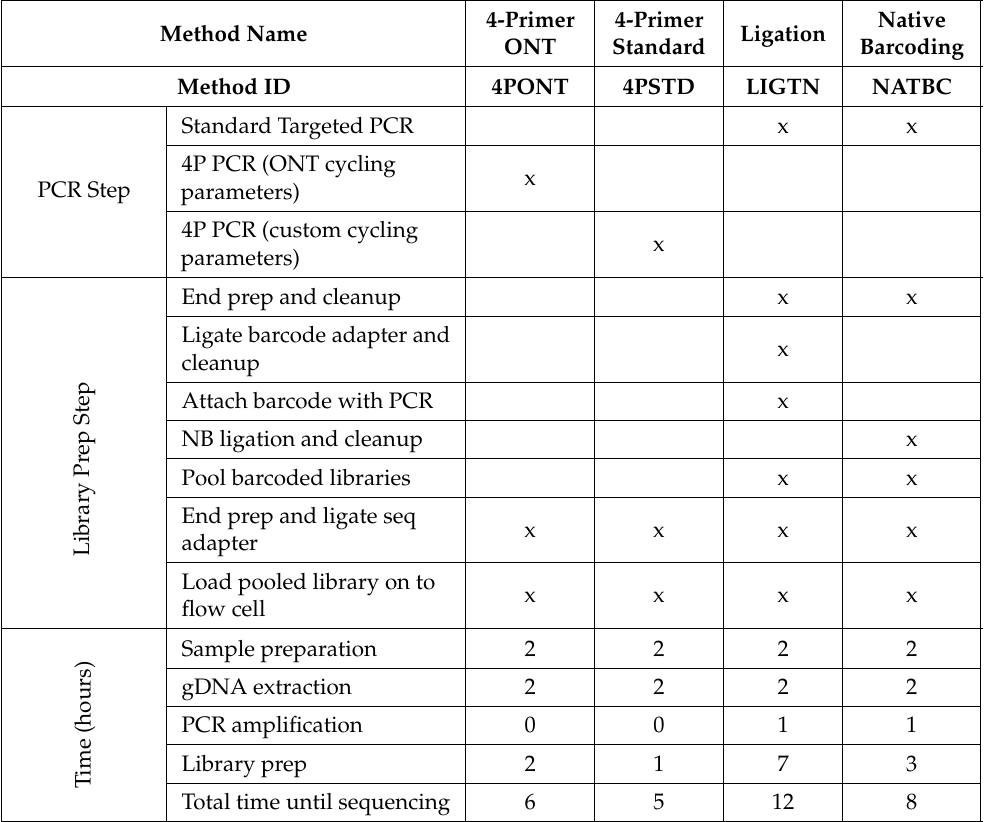
Table 1. Overview of ONT library preparation protocols. Four ONT library preparation protocols are shown with major PCR and sequencing library prep steps indicated. An ‘x’ indicates that the corresponding protocol step is required for the method. The various steps for “Sample preparation” and “gDNA extraction” rows under Time are not broken down in this table but would include activities such as sample collection, elution, cell lysis, and DNA